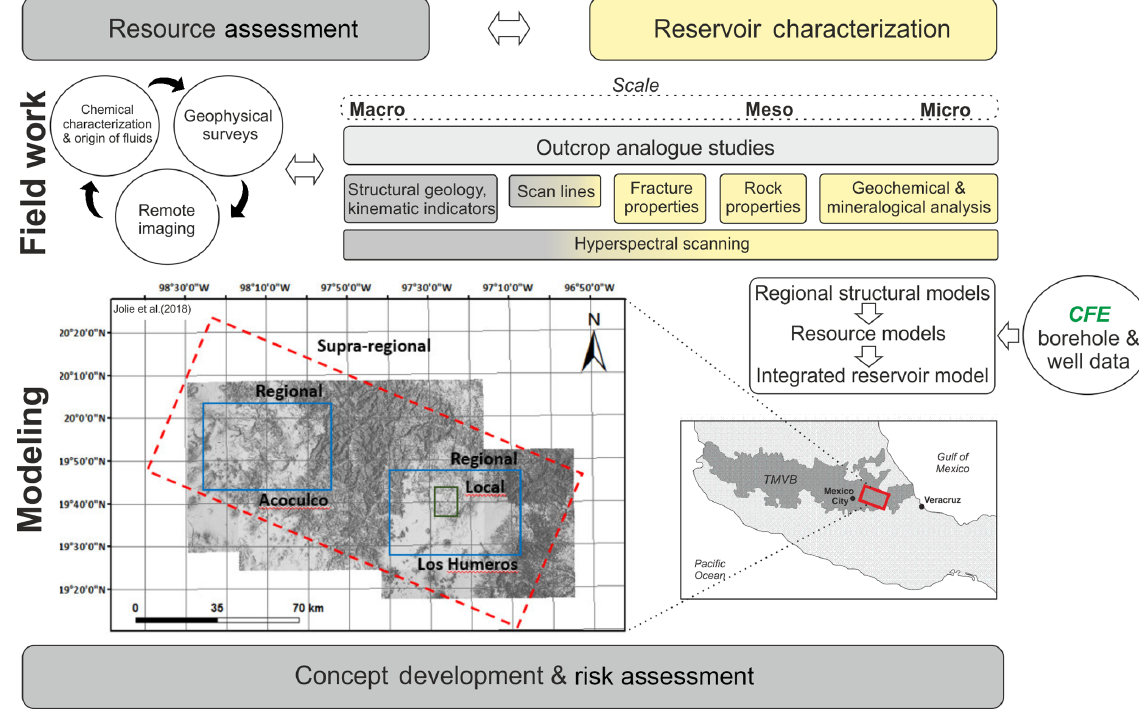
Figure 1. Simplified work flow within the GEMex